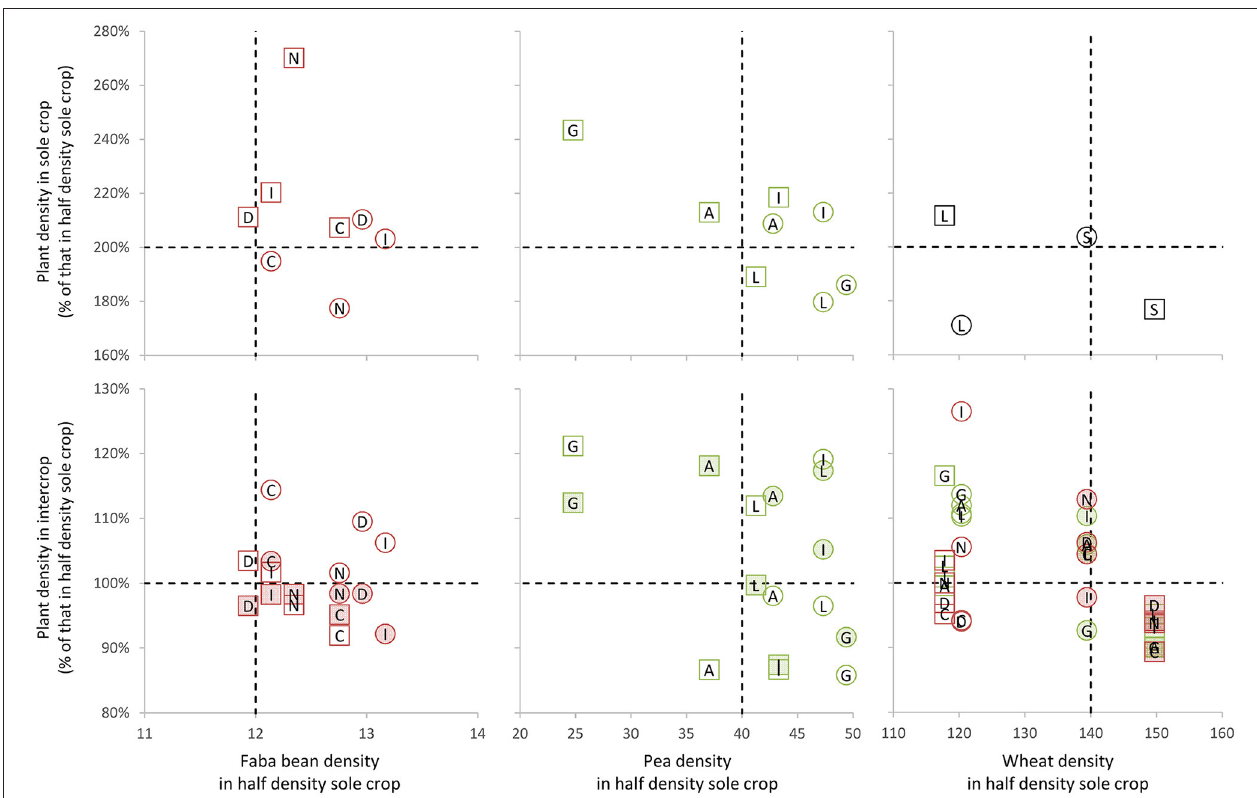
FIGURE 2 | Comparison of the plant densities in intercrop (IC) and sole crop (SC) vs. half density sole crop (SC ½ ). The plant density in IC or SC as a function of that in SC ½ . The circles correspond to Exp.I and squares to Exp.II. For the ICs, open symbols correspond to L1823 wheat cultivar and closed ones to Sculptur wheat cultivar. Each point corresponds to the means of the three replicates’ data. The vertical dotted lines correspond to the targeted density for the SC ½ . The horizontal dotted lines correspond to the expected densities in IC and sole crop vs. SC ½ . The letters within the symbols correspond to the first letter of the cultivar for SC vs. SC ½ and to the first letter of the associated cultivar in IC vs. SC ½